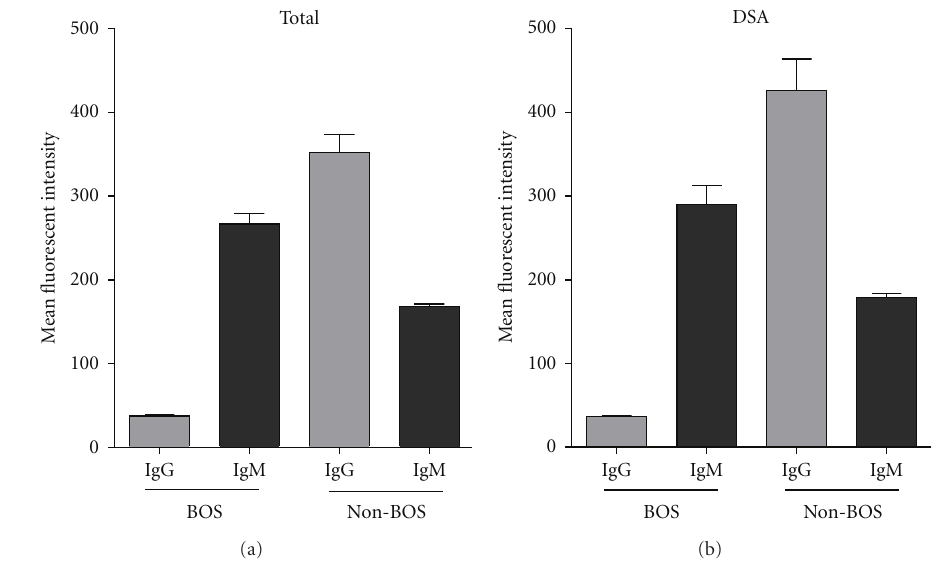
Figure 5: Mean fluorescent intensities of HLA class I antibodies. (a) All HLA class I antibodies of both IgG and IgM isotype in BOS and non-BOS patients. (b) Possible DSA HLA class I antibodies of both IgG and IgM isotype in BOS and non-BOS patients. Error bar depicts the standard error of